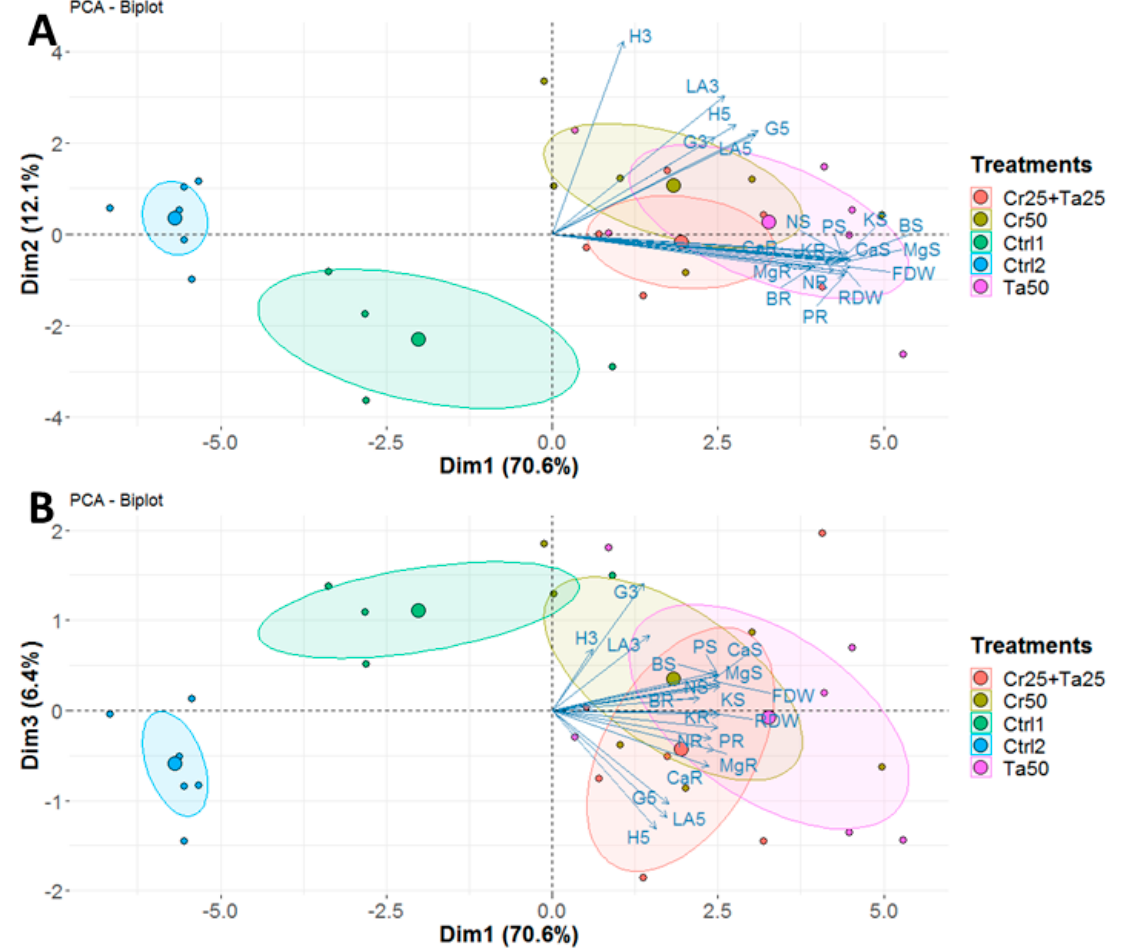
Figure 7. Principal component analysis (PCA) plots generated using ( A ) first and second dimensions and ( B ) first and third dimensions, based on various plant vegetative growth measurements and plant nutrient analyses for three treatments (Cr50, Ta50 and Cr25 + Ta25) and two controls (Ctrl 1 and Ctrl